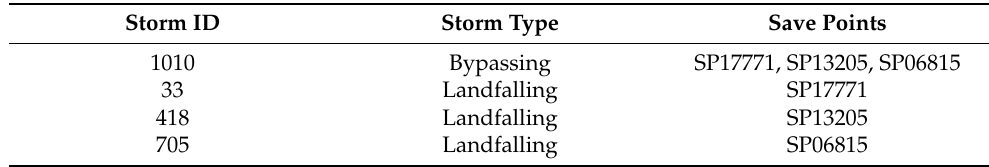
Table 7. Four representative test storms for time-series storm surge analysis at three save points. There are one bypassing storm and three landfalling storms, with each making landfall near one save